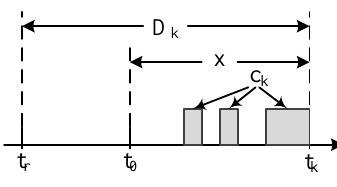
Figure 5. Illustration of Theorem